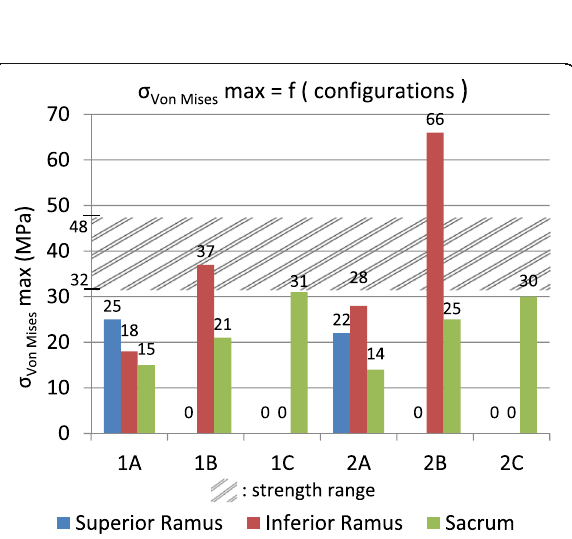
Fig. 5 σ Von Mises max in the models. 1 : Position 1. 2 : Position 2. A : Non-fractured pelvis. B : Right superior ramus fractured pelvis. C : Right superior and inferior rami fractured